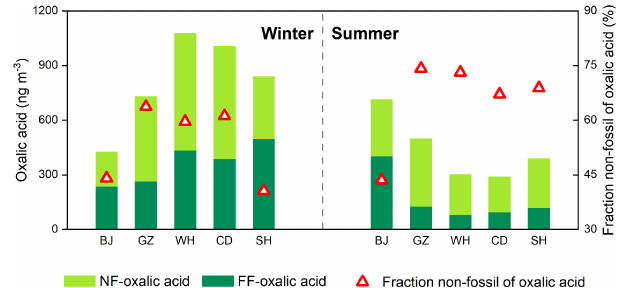
Figure 2. Mass concentrations of oxalic acid derived from non- fossil sources (NF) and fossil fuel (FF) and the mean proportions of non-fossil oxalic acid found for Beijing (BJ), Guangzhou (GZ), Wuhan (WH), Chengdu (CD), and Shanghai (SH) in winter and summer.